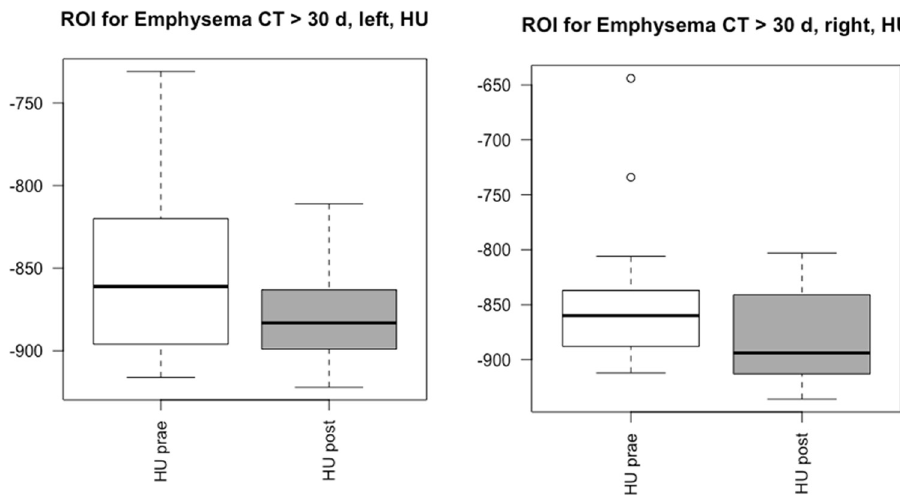
Fig 5. Boxplot for attenuation values. Manually measured attenuation values by ROIs in unaffected lung areas show no differences in the groups > 30 days and < 30 days between initial CT scan (white) and follow-up CT scans